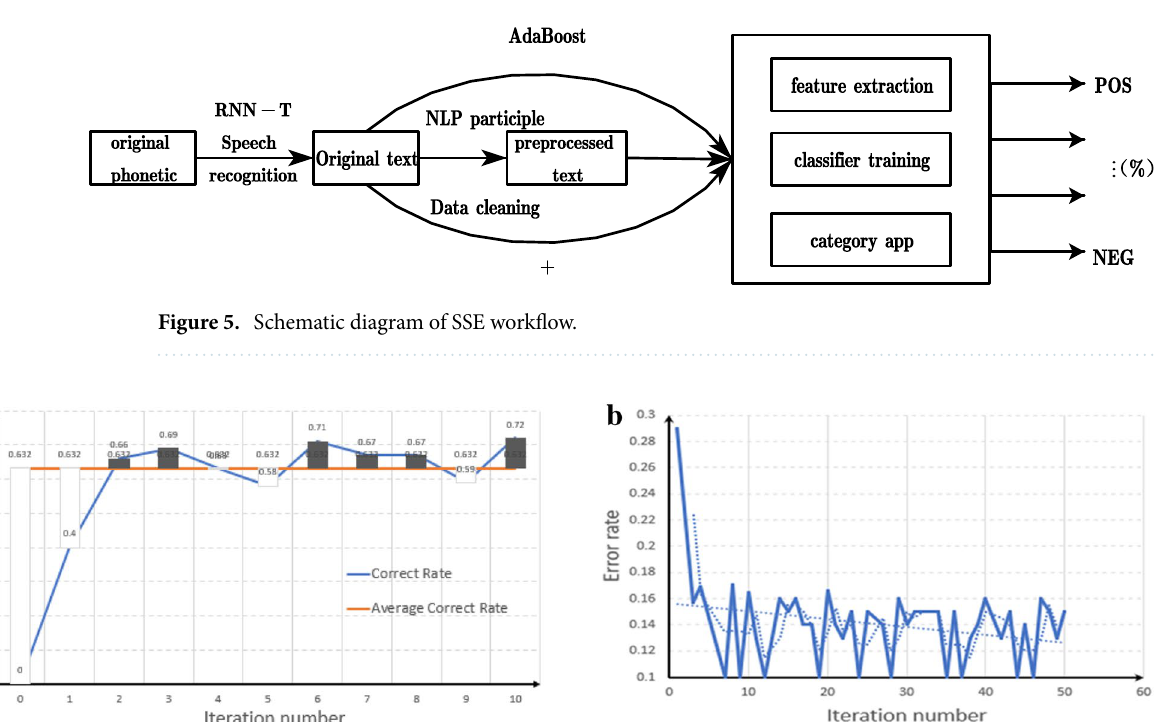
Figure 6. Schematic diagram of the accuracy rate of the two methods. ( a ) Accuracy of plain Bayesian. To ensure the efficiency of the method, attention is paid to the performance effect during the initial period, when the effect curve shows a good climbing ratio of 33 n/C r (n → Smaller) with only the initial number of iterations, when the threshold of the mean correct rate is exceeded and increases exponentially as the program progresses. ( b ) Schematic diagram of binary classification accuracy. Recognition efficiency is greatly improved when the program acquires steep change curves as it carries out the learning process and fluctuates to reduce the recognition error rate to within a reasonable upper and lower threshold interval in accordance with fitting the expected mean-expectation